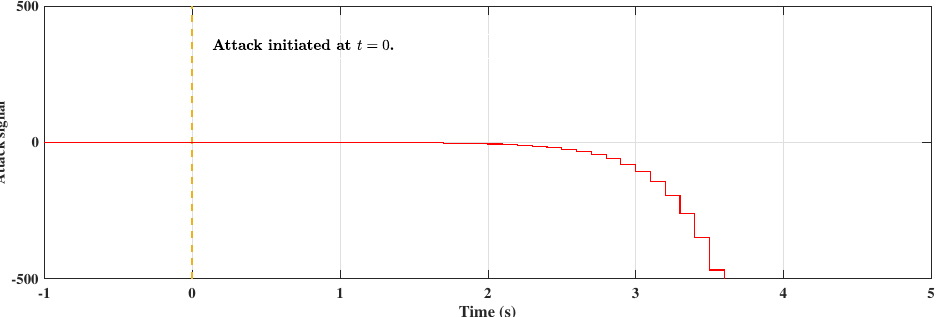
Figure 6. Zero-dynamics attack a k signal when T s = 0.1 s.